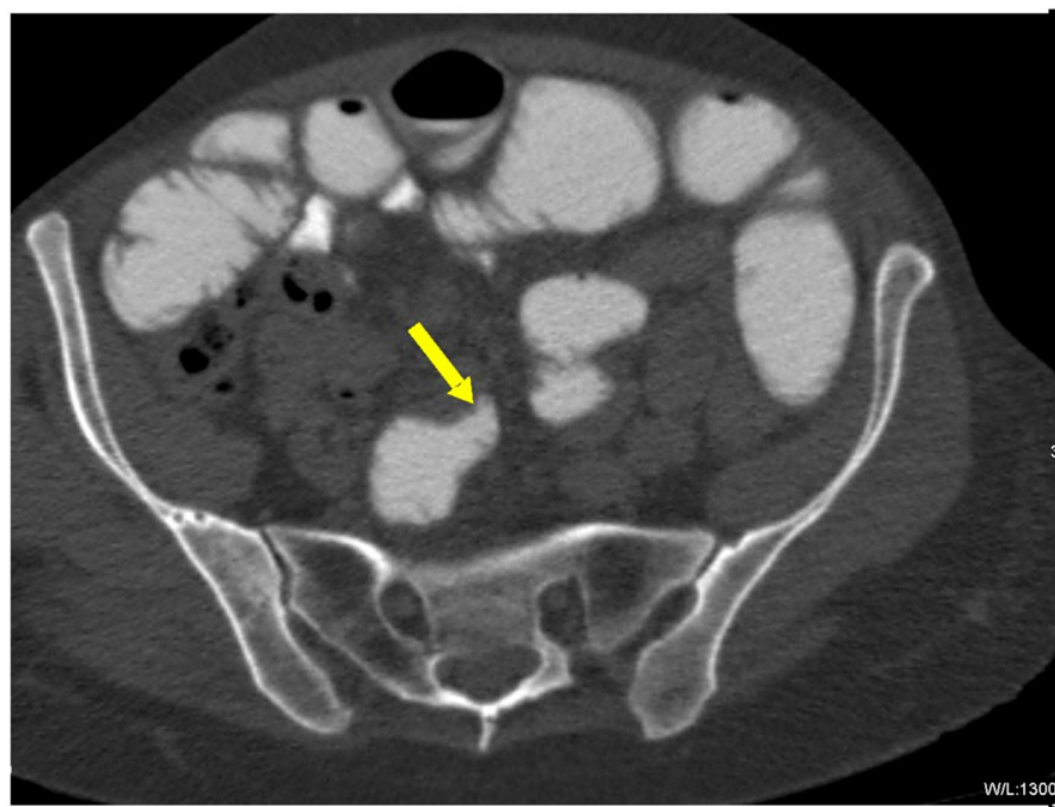
Figure 1c: Axial CT showing SBO with abrupt transition point (yellow arrow) with no associated mass in keeping with an adhesive band, confirmed at surgery